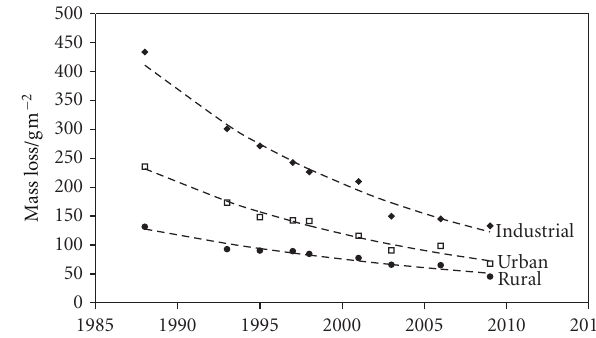
Figure 5: Carbon steel corrosion for industrial, urban, and rural ICP Materials test